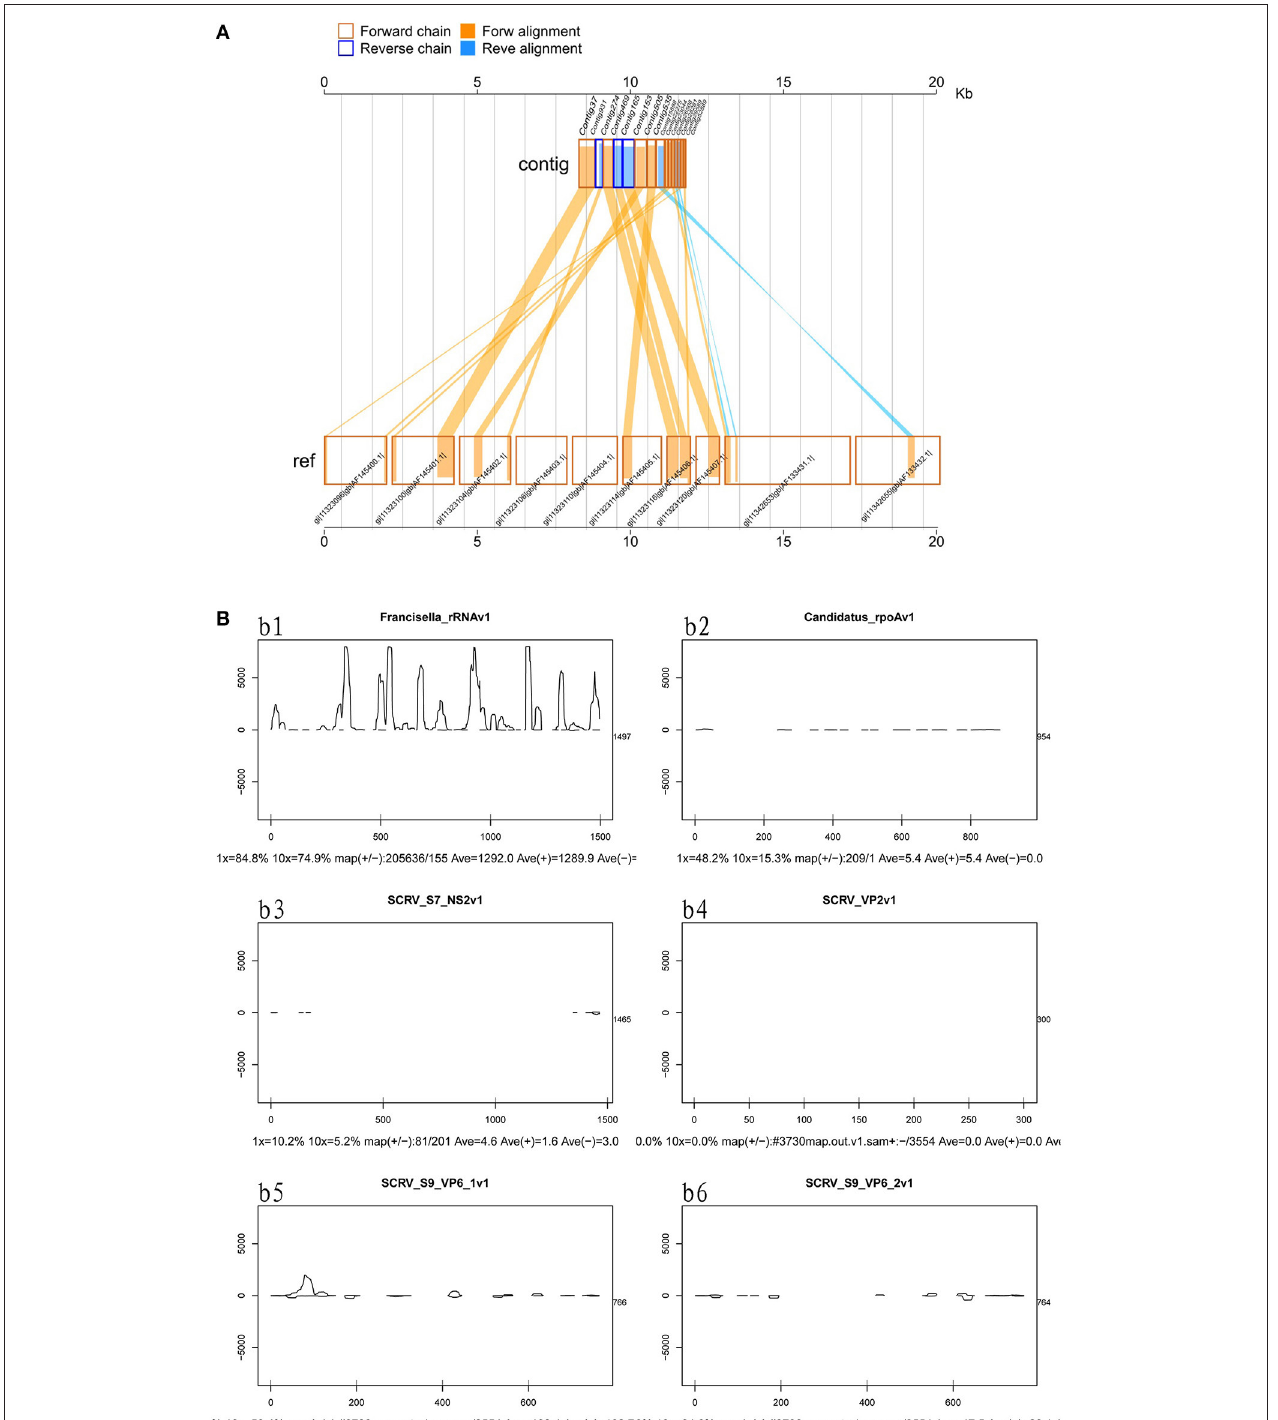
FIGURE 3 | Mapping of micropathogen sequencing reads to genomes. (A) Cleaned sequence reads were mapped to the SCRV virus genome (GenBank accession number PRJNA14941). The SCRV genome contains 10 open reading frames (Vp1, Vp2, Vp3, Vp4, Vp5, Vp7, Vp9, Vp10, NS1, and NS2), which are flanked by inverted repeats and direct repeats at both termini of the genome. Dashed lines represent the regions to which sequenced reads were mapped. Yellow indicates the coverage (occurrence frequency) of the sense strand reads, and blue indicates the coverage of the antisense strand reads. (B) Small RNA mapping to the reference genome sequences of the corresponding micropathogens. b1–b6: These figures indicate deep coverage of the virus genome by the small RNA map following use of